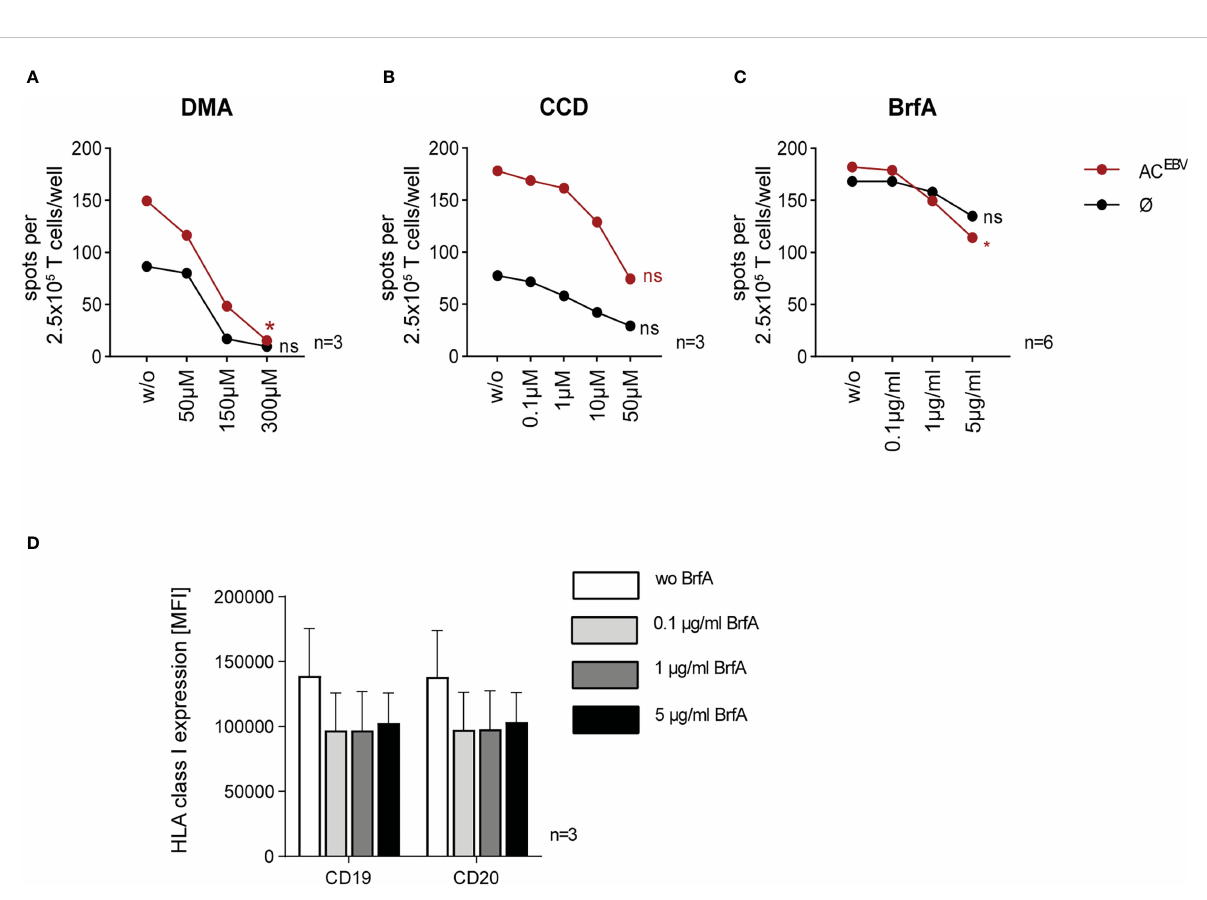
FIGURE 4 Reduction of EBV-speci fi c T-cell responses by inhibiting parts of the cross-presentation pathway in AC EBV -loaded B-LCLs. Cross-presentation of AC EBV by B-LCLs investigated by in vitro inhibition assays (22). B-LCLs pretreated with increasing concentrations of (A) dimethyl amiloride (DMA, 0 to 300 µM, n=3) and (B) cytochalasin D (CCD, 0 to 50 µM, n=3) before loading with the EBV antigen cocktail (AC EBV ). Using (C) brefeldin A (BrfA, 0 to 5 µg/ml, n=6) cells were treated after AC EBV -loading. For control, with inhibitors treated unloaded B-LCLs (Ø) were used. Speci fi c T-cell responses monitored by IFN- g EliSpot assay using autologous 2.5 x 10 5 CD3 + T cells as effector cells and inhibitor-treated B-LCLs at an E:T ratio of 10:1. (D) Mean fl uorescence intensity (MFI, n=3) of HLA class I expression on CD19 + and CD20 + B-LCL in the presence of different BrfA concentrations. Results of